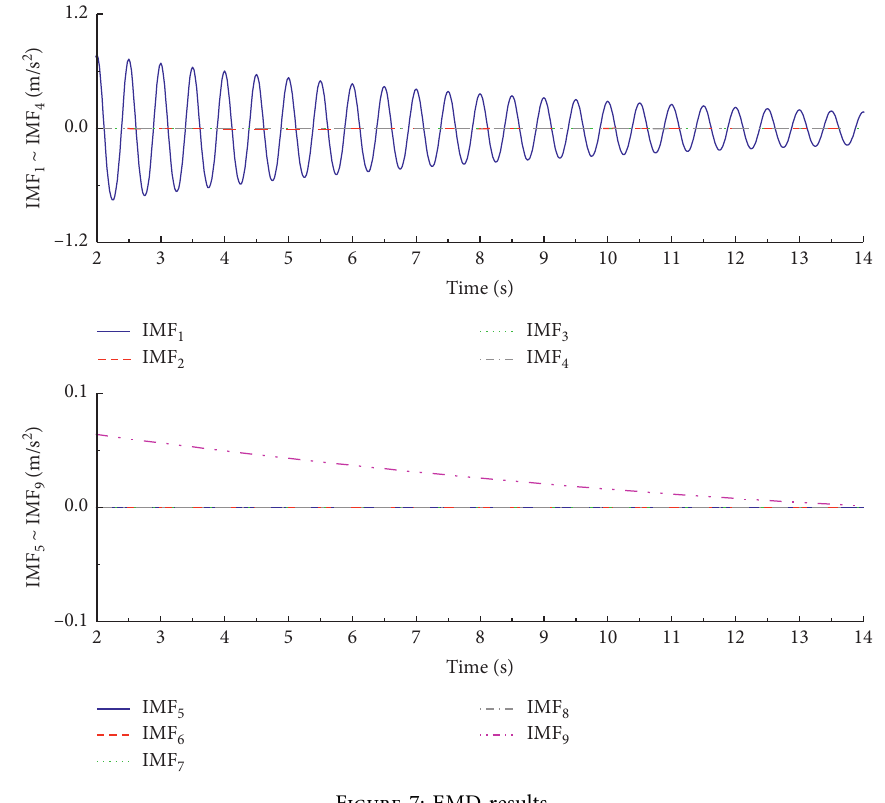
Figure 7: EMD results.